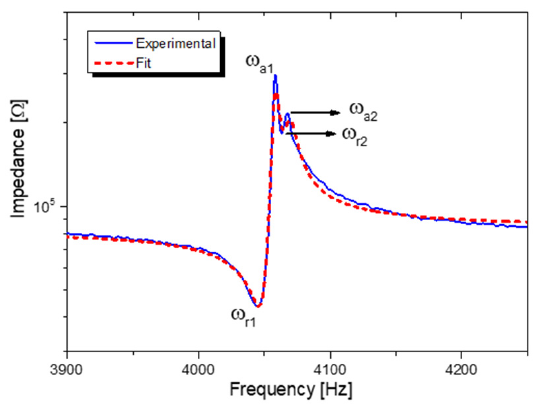
Figure 6. Impedance measurements for the LiNbO 3 element.